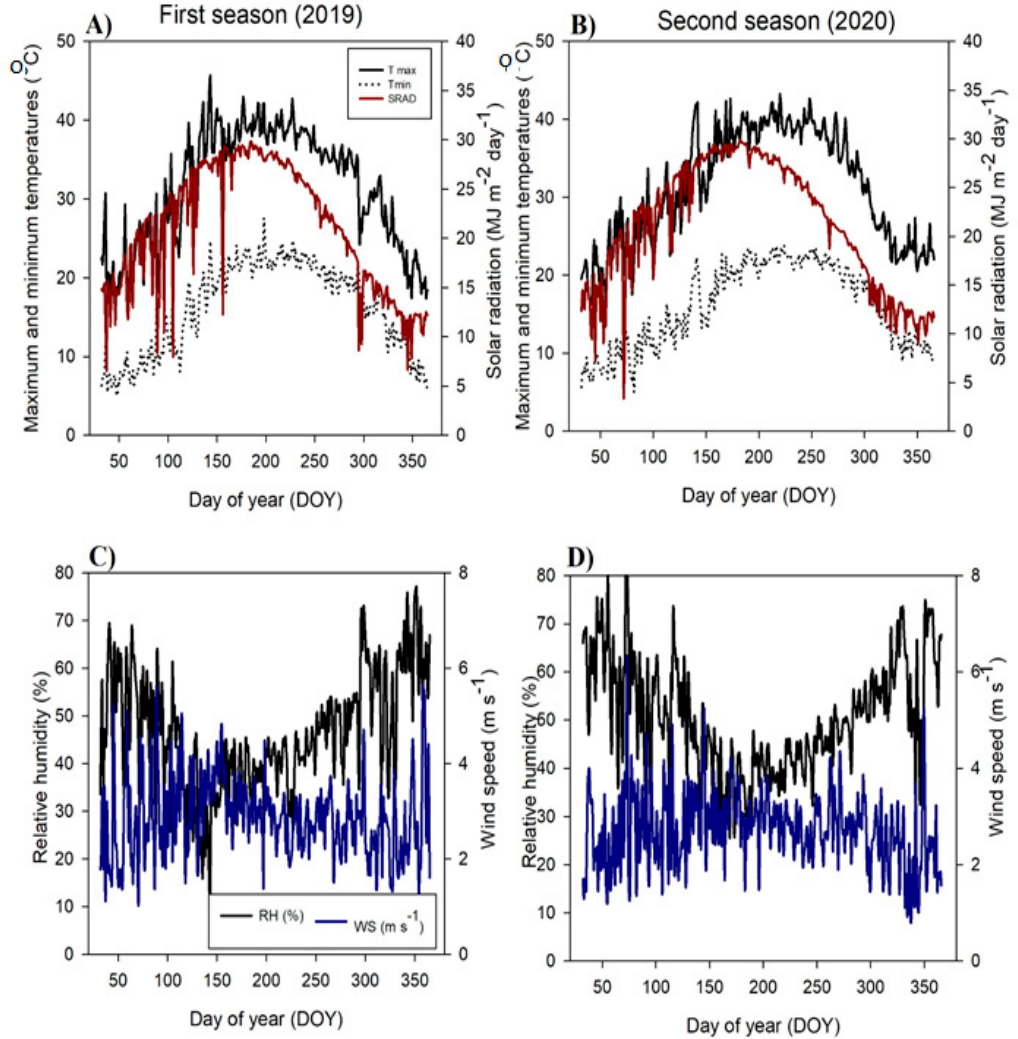
Figure 3. Daily climatic data as maximum temperature, minimum temperature, and solar radiation ( A , B ), as well as relative humidity and wind speed ( C , D ) over two seasons in the studied area.